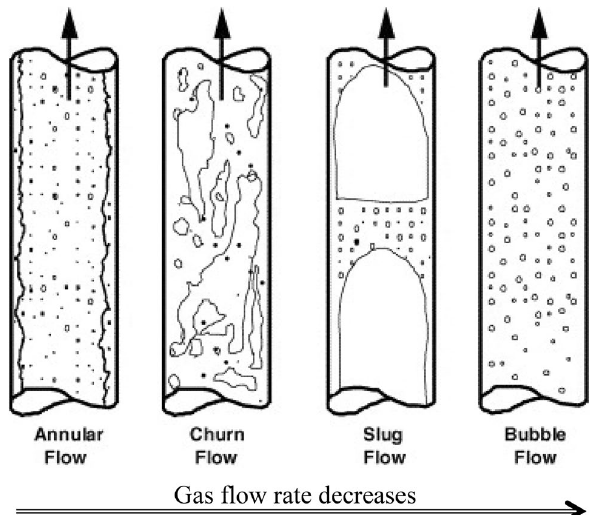
Fig. 1 Two-phase flow patterns of a gas–liquid flow in a vertical